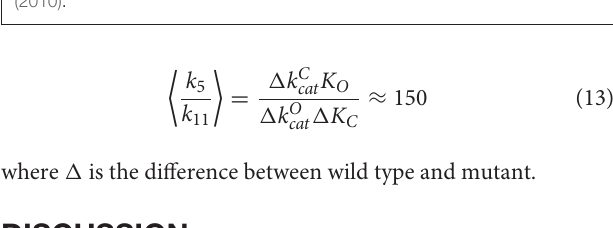
FIGURE 7 | Oxygenation parameters. Scatter plots of (A) k O cat against k C cat (B) K O against k C cat and (C) specificity, S O = k Table 1 . Data points highlighted in green are those compiled by Savir et al. (2010).